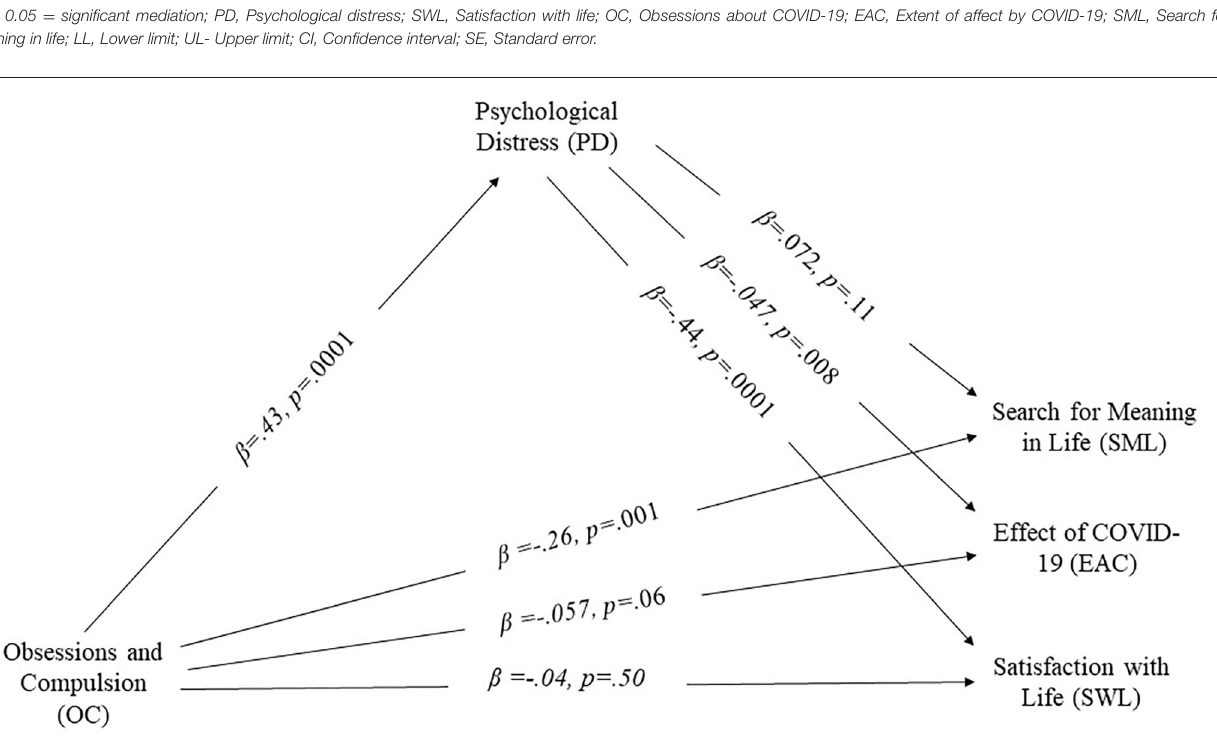
FIGURE 3 | Alternate mediation